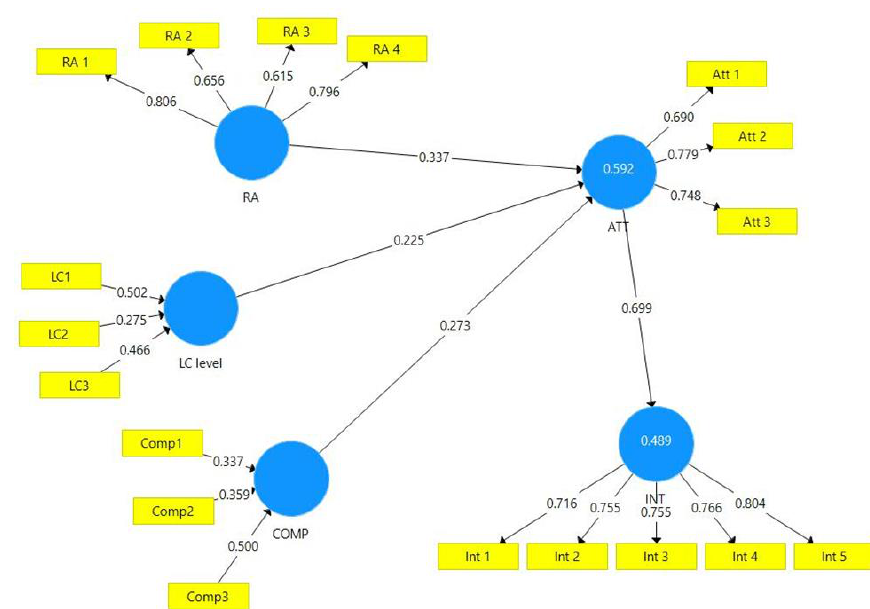
Figure 5. Integrated framework of TAM and DOI theory.